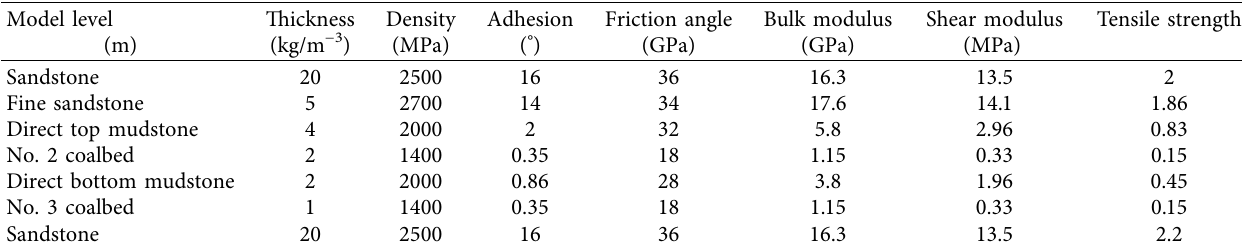
Table 2: Parameters of physical and mechanical properties of various coal and rock layers. Model